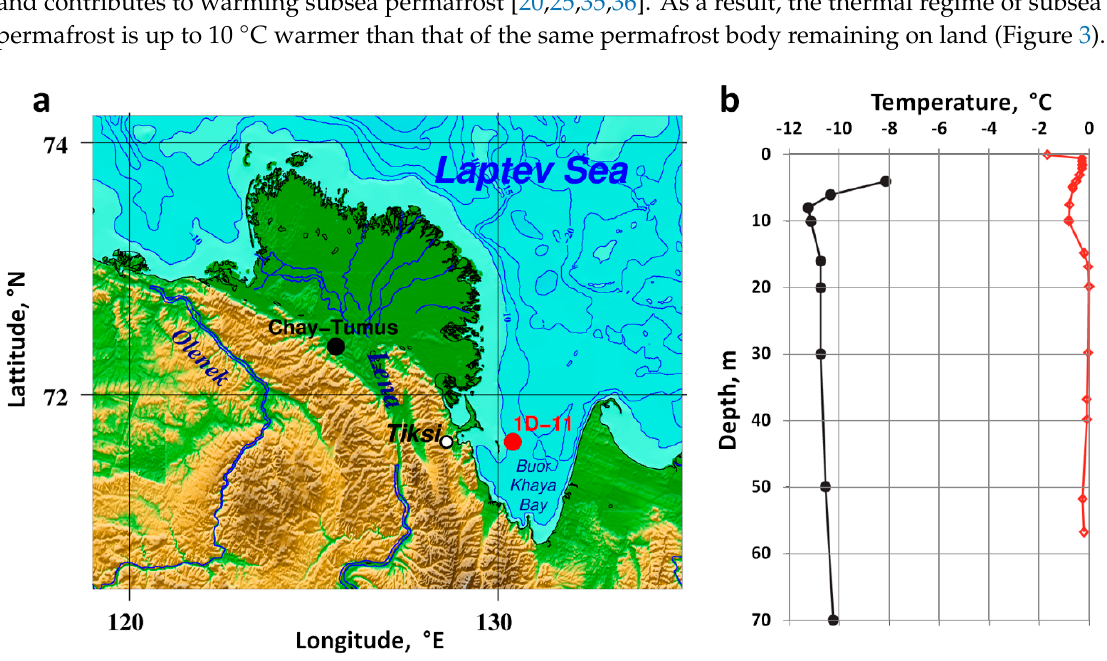
Figure 3. An example of the di ff erence in thermal regimes of terrestrial and subsea permafrost in the coastal zone of the ESAS. ( a ) The position of the borehole performed in the Lena Delta (Chay-Tumus) is marked by a black dot; a borehole in the near-shore zone (Buor-Khaya Bay, borehole 1D-11) is marked by a red dot. ( b ) The black curve shows sediment temperatures at di ff erent horizons of the Chay-Tumus sediment core [38]; the red curve shows sediment core temperatures obtained in Buor-Khaya Bay. As seen from panel B, sediments in the 1D-11 borehole are much warmer (from − 2 ◦ C to 0 ◦ C) than terrestrial Chay-Tumus sediments (from − 8 ◦ C to − 11.5 ◦ C), modified from [20].